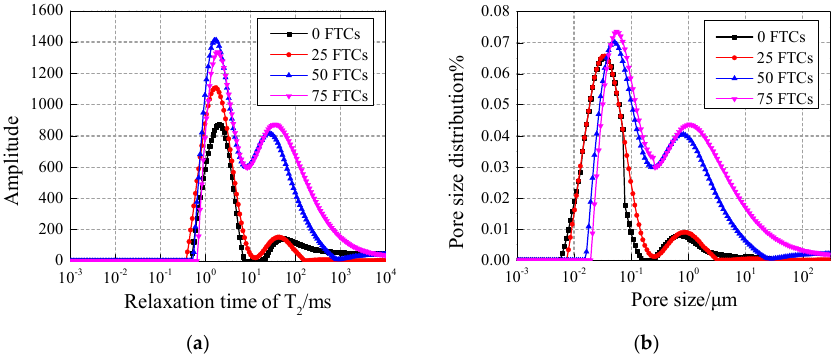
Figure 10. ( a ) T 2 spectrum and ( b ) pore fluid size distribution of 30 nm-NS added